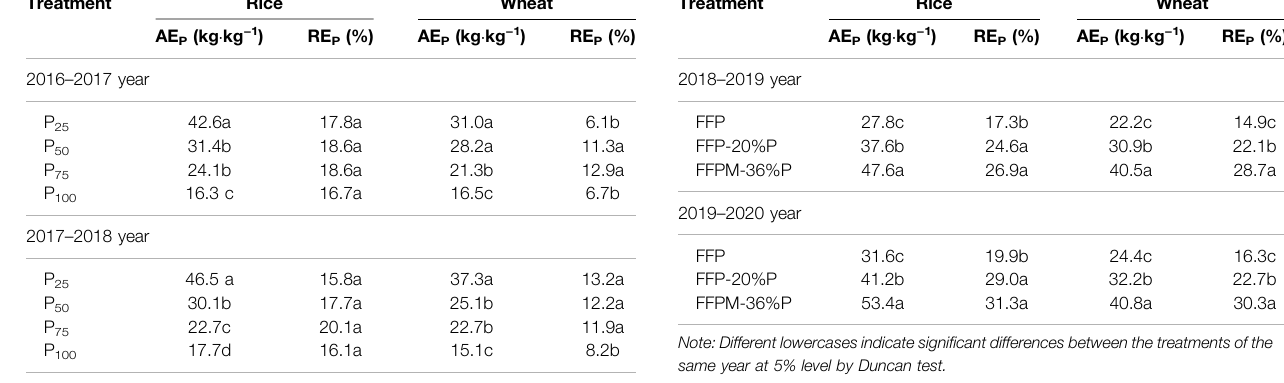
TABLE 8 | Effect of P fertilization rates on P use ef fi ciency. Treatment Rice Wheat